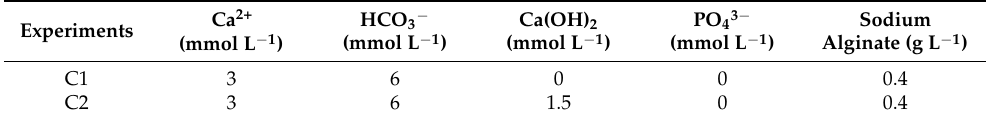
Table 3. Effect of sodium alginate, calcium, and softening on fouling.